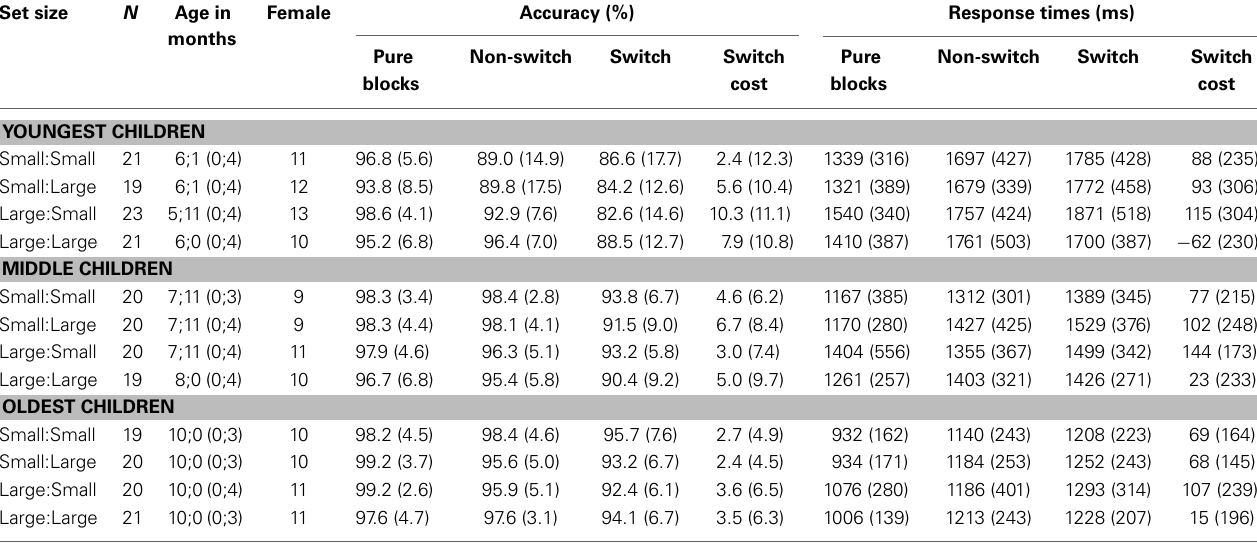
Table 2 | Mean accuracy rates and response times by trial type in Experiment 2. Set